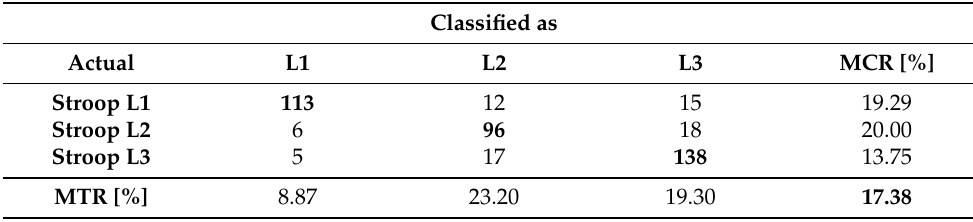
Table 4. Confusion table for the sequence classification for the pilot cohort. Correctly classified screens are counted on the diagonal (in